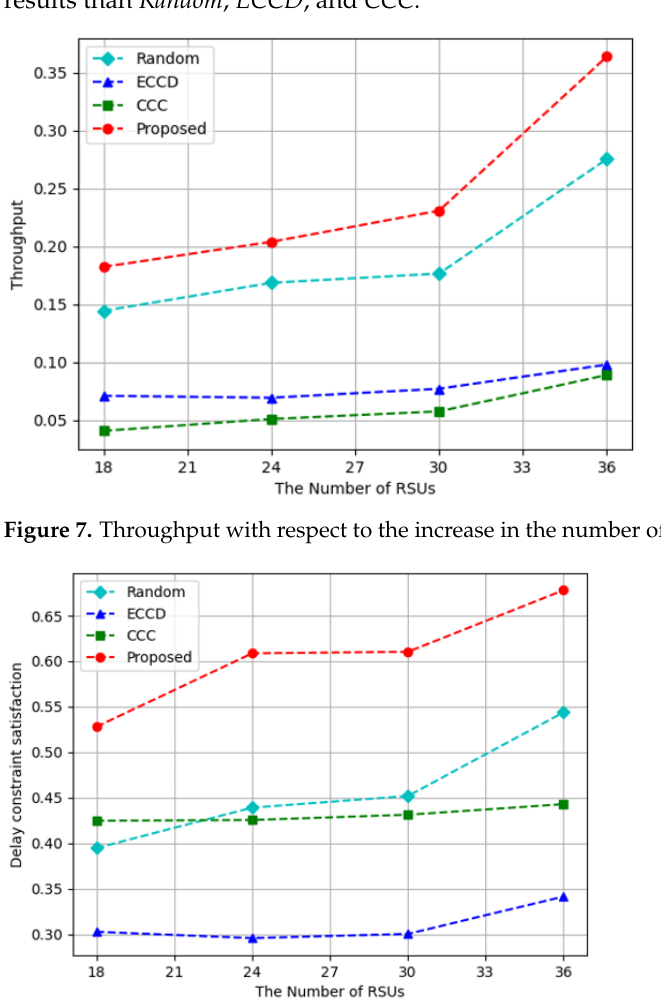
Figure 8. Delay constraint satisfaction with respect to the increase in the number of RSUs.